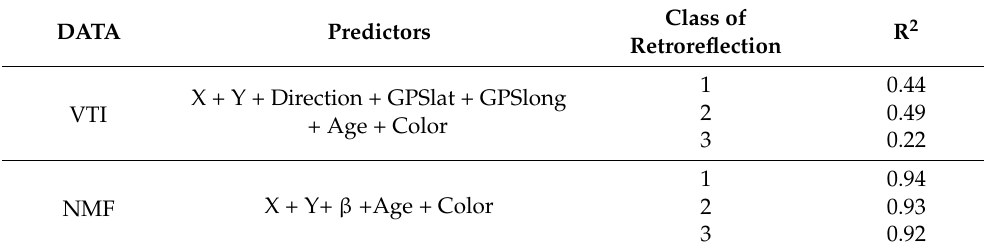
Table 5. R 2 values for each class for VTI and NMF data (using logarithmic regression). DATA